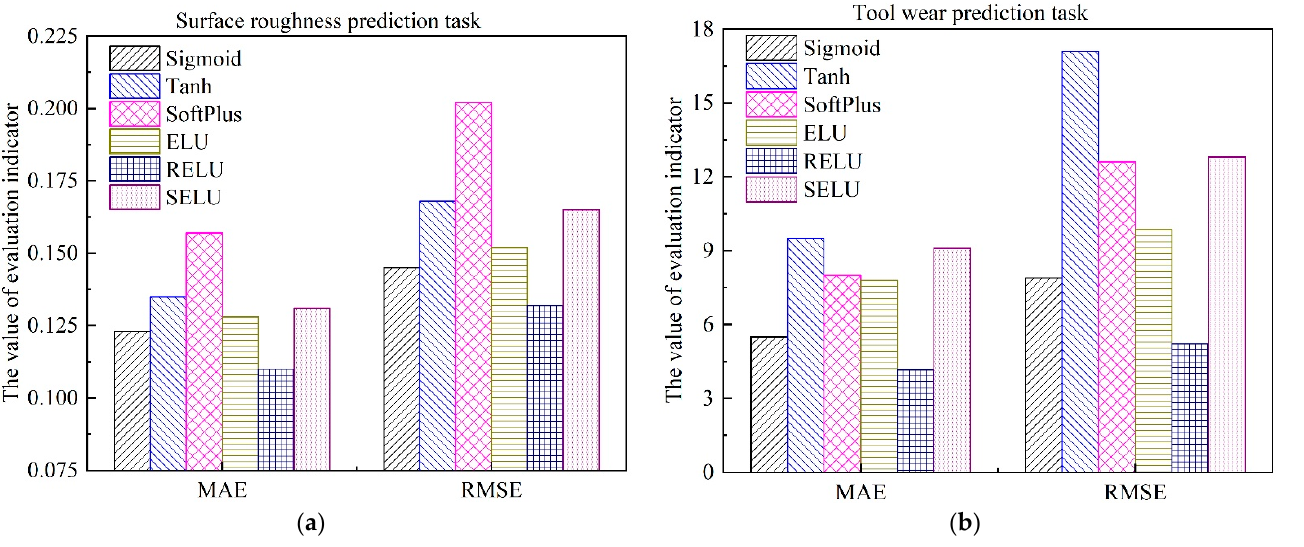
Figure 13. Performance comparison of different activation functions of SCAE, and the activation function of SDAE is SELU. ( a ) Surface roughness; ( b ) Tool wear.